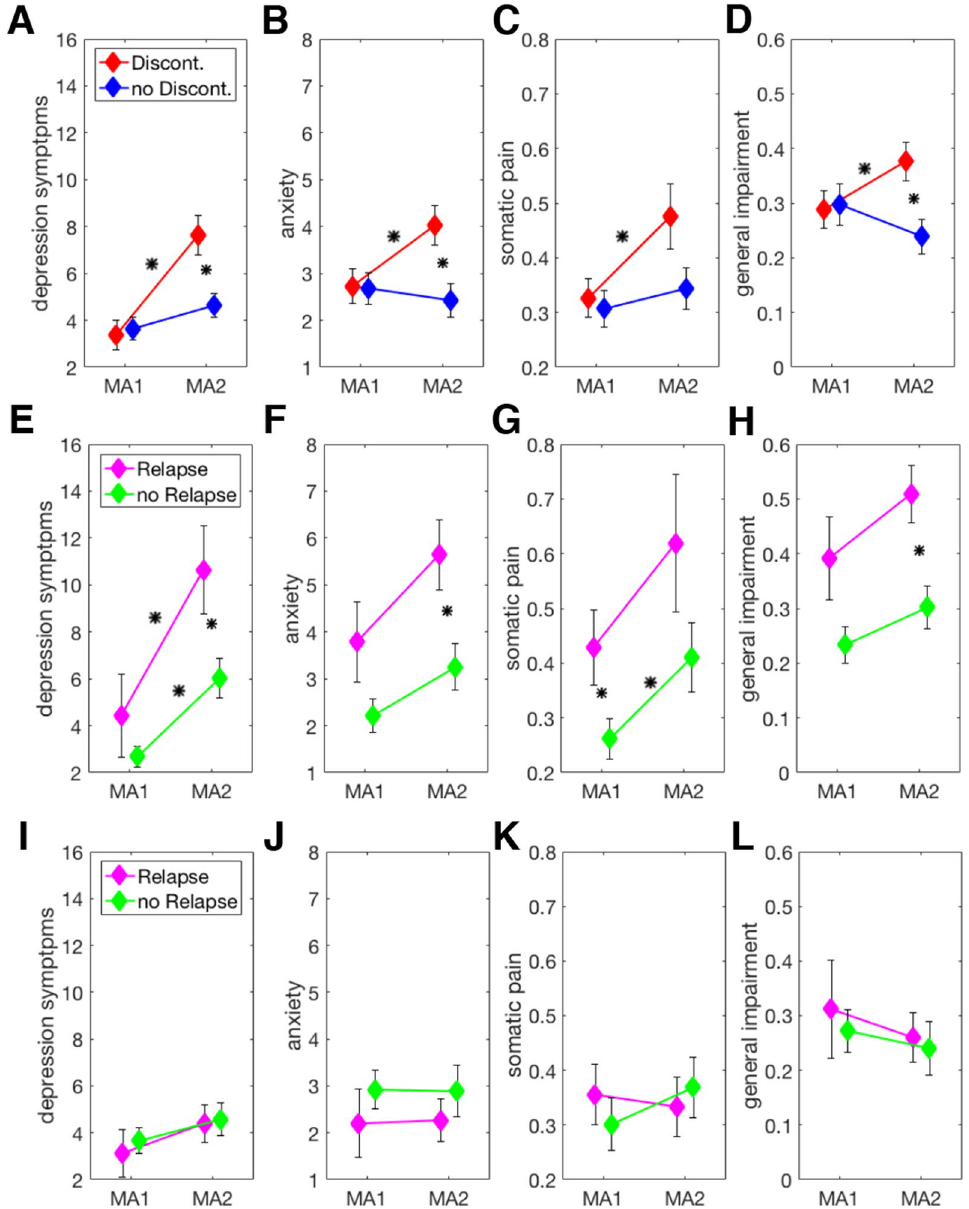
Figure 3. ( A – D ) Discontinuation effects: changes in symptoms from main assessment one (MA1) to main assessment two (MA2) for depression ( A ), anxiety ( B ), somatic pain ( C ) and general impairment ( D ) in patients who discontinued between the two assessments and patients who did not discontinue. ( E – H ) Discontinuation relapse interaction effects: Changes in symptoms from MA1 to MA2 for depression ( E ), anxiety ( F ), somatic pain ( G ) and general impairment ( H ) in patients who discontinued and either relapsed or remained well during the follow-up period. ( I – L ) Test–retest reliability for symptom measures: Changes in symptoms from MA1 to MA2 for depression ( I ), anxiety ( J ), somatic pain ( K ) and general impairment ( L ) in patients who did not discontinue and either relapsed or remained well during the follow-up period. Asterisks indicate a significant difference at p < 0.05 for FDR-corrected p values. Asterisks on top of a line relate to a within-subjects difference between MA1 and MA2 for the group indicated by the line. Asterisks between two lines relate to a between- subjects difference at the indicated time